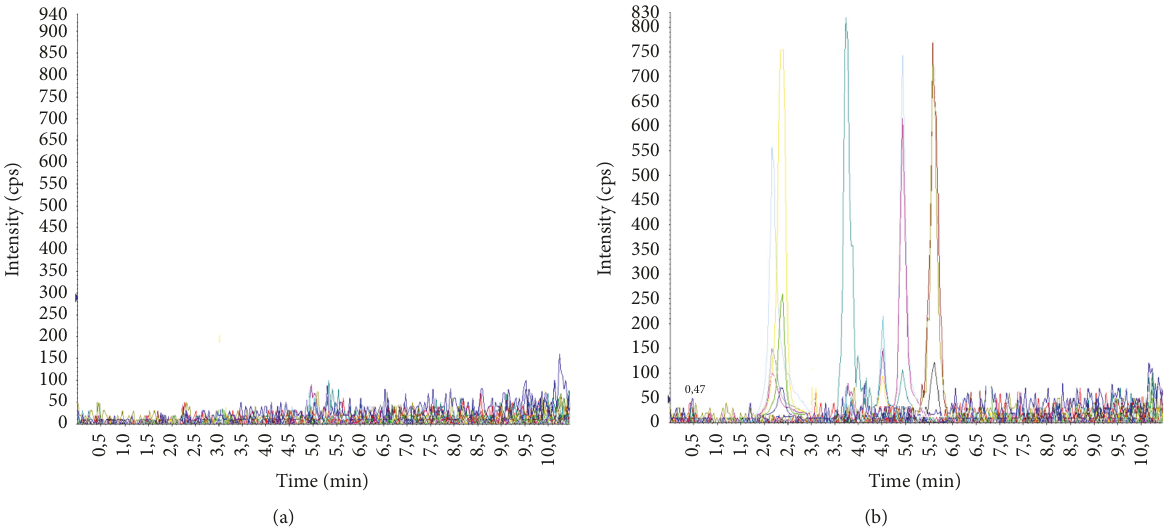
Figure 2: MRM chromatogram of free blank plasma (a) and blank plasma sample spiked with antipsychotics at LOQ (b) (chlorpromazine (1.70 ng/ml), haloperidol (0.49 ng/ml), levomepromazine (2.26 ng/ml), olanzapine (1.01 ng/ml), risperidone (0.52 ng/ml), and sulpiride (1.82